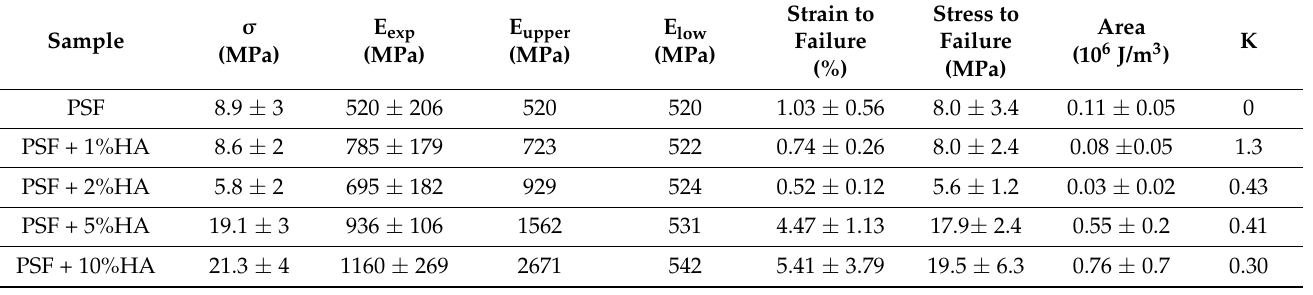
Table 4. Mechanical parameters obtained for the samples of PSF/HA from the mechanical tests.